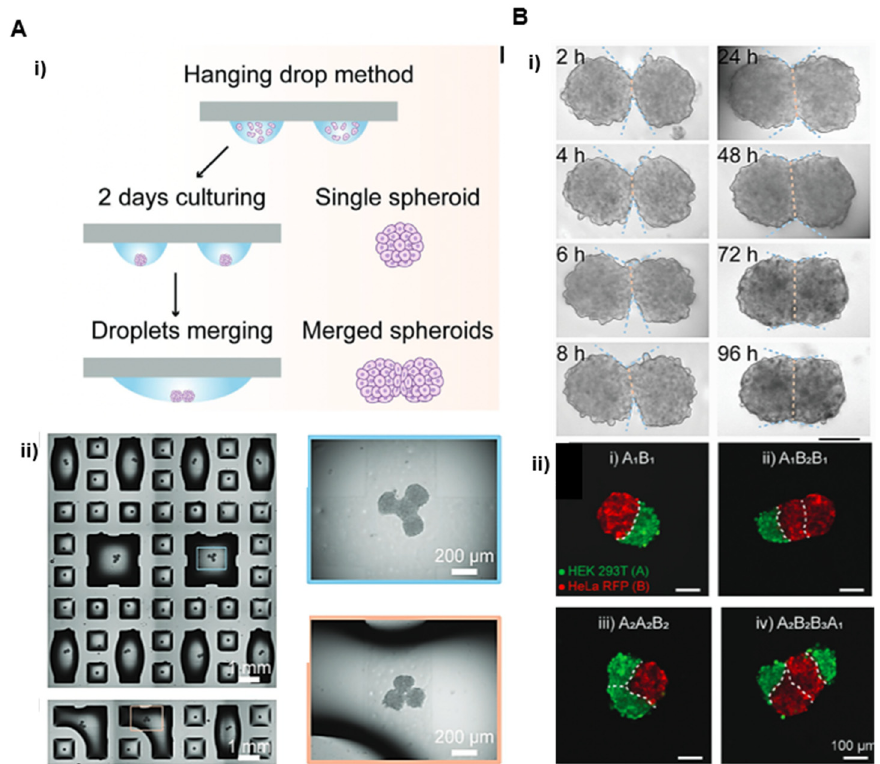
Figure 5. Programmable hanging drop method to form arrays of spheroids Reprinted with permission from Ref. [35]. Copyright 2020, John Wiley and Sons. ( A ) Merging of adjacent droplets. (i) Schematic of the hanging drop method to form arrays of cell spheroids using hydrophilic spots divided by superhydrophobic borders (ii) Micrograph of an array containing 2, 3, and 4 merged droplets (left side) and enlarged images of fused spheroids in merged droplets after 24 h (right side). ( B ) Examples of multi-spheroid architectures formed by this method. (i) Micrographs of two HepG2 spheroids fusing step by step over 96 h. (ii) Fluorescence microscopy images of hetero-spheroid architectures built from two different cell lines (HeLa cells expressing RFP and HEK 293T stained with green 24 h post merging. Scale bars 100 μ m.